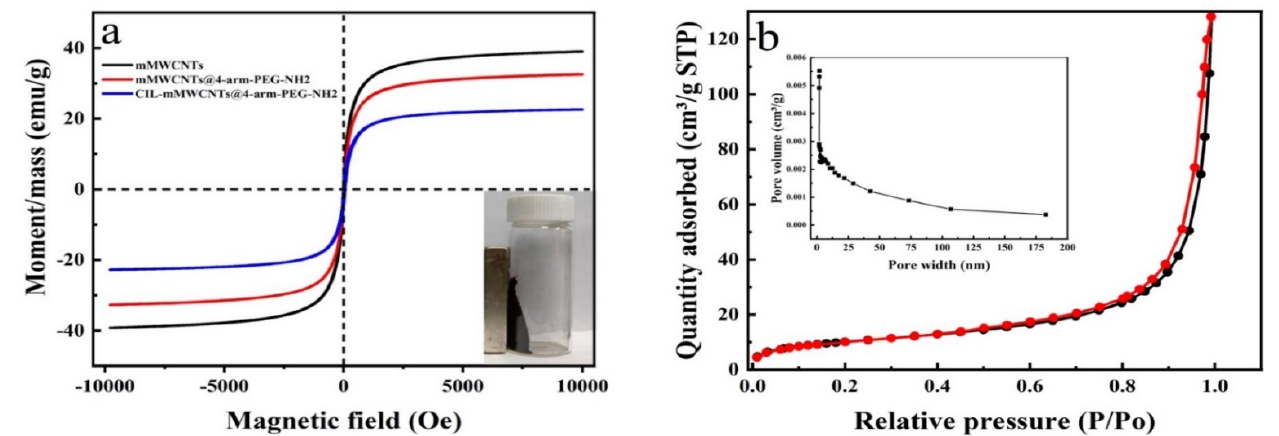
Figure 6. Magnetic characteristics, surface area, and pore size of mMWCNTs support. ( a ) Magnetic hysteresis curves of mMWCNTs samples; the insert photographic image shows CIL-mMWCNTs@4-arm-PEG-NH 2 attracted by an external magnet. ( b ) Surface area and pore size analysis for mMWCNTs@4-arm-PEG-NH 2 .